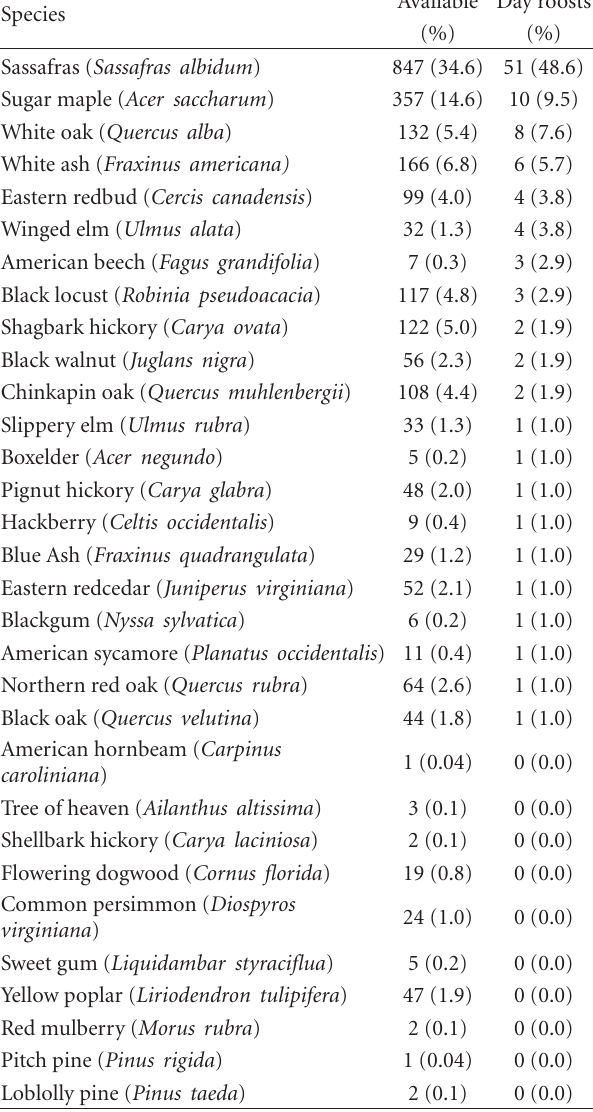
Table 2: Female Myotis septentrionalis day roosts by species and the number of corresponding potential day roosts (%) in a mesophytic forest on the Fort Knox military reservation in Hardin, Bullitt and Meade counties, Kentucky, USA, 2011. Available roosts were those trees with visible cavities or exfoliating bark found on 20 × 100 m belt transects oriented at random azimuths from each day